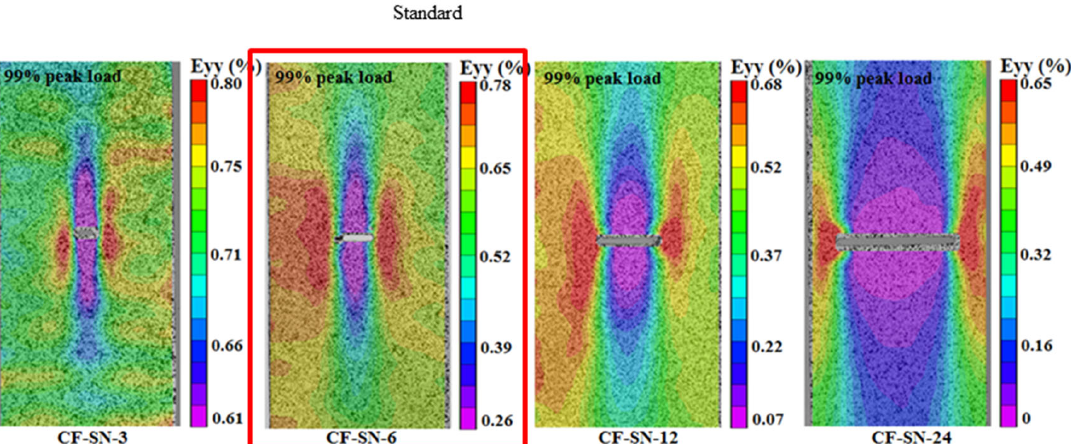
Figure 10. Strain field distribution of straight ‐ notched specimens with the same specimen size (W) under a 99% ultimate tensile load; the strain concentration area extends in the specimen with a large notch towards the left/right edge of the specimen.